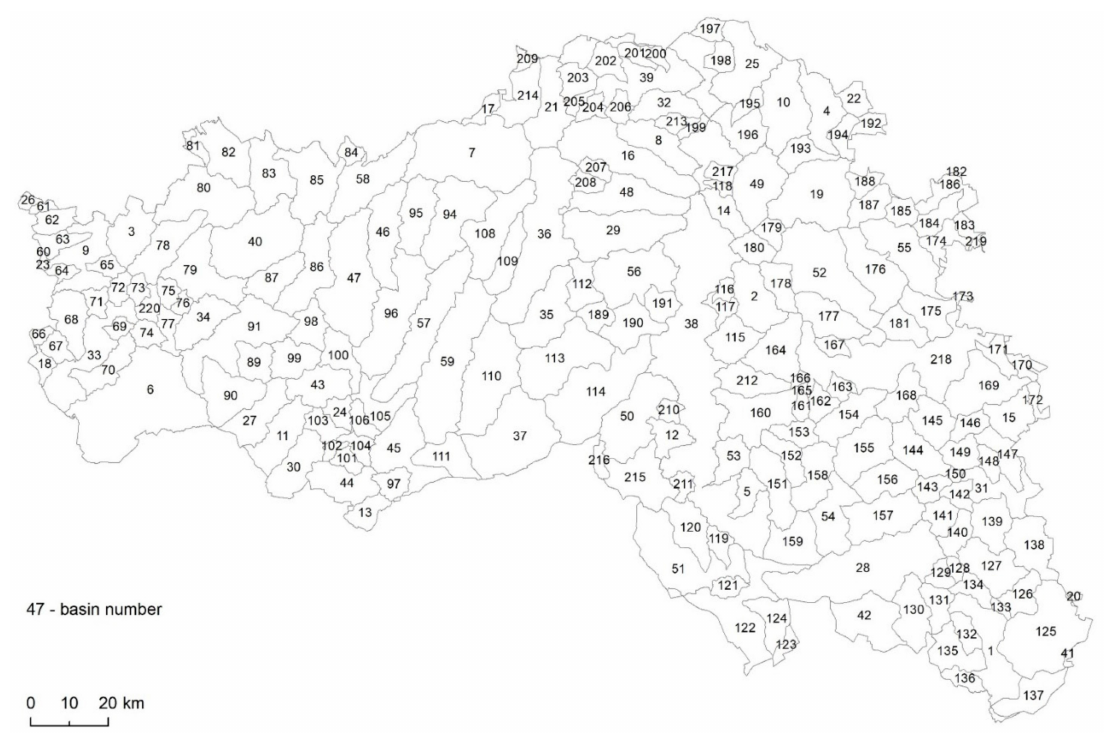
Figure A1. Location of the studied river basins in Belgorod Oblast (see Table A1). Table A1. Parameters for calculating the average annual soil loss in the studied river basins of Belgorod Oblast (see Figure A1). M1—for bare (clean) fallow conditions; M2—for the actual structure of sown areas; M3—for ALAS